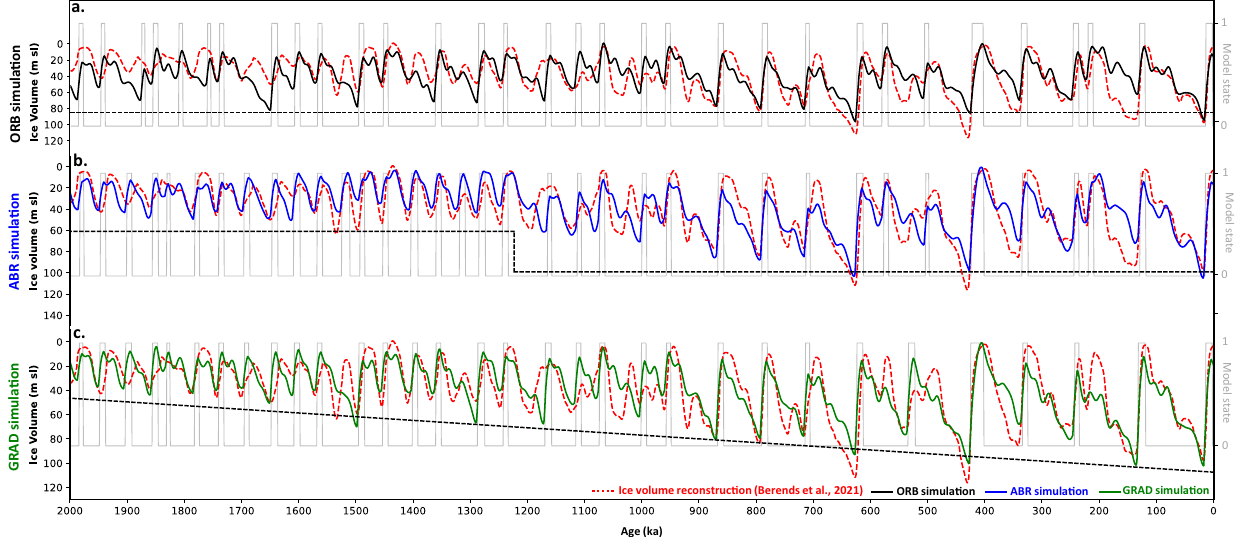
Fig. 1 Simulated and reconstructed global ice volume variations (in metre sea level equivalent, msl) over the last 2 Ma. The ORB ( a , black curve), ABR ( b , blue), and GRAD ( c , green curve) simulations are superimposed onto the reconstructed global ice volume (red dashed curves) from ref. 41 . For each simulation, the grey curve represents the state of the model, deglaciation (1) or glaciation (0) and the evolution of a key model parameter is indicated as a dashed black line. In the ORB simulation, the v 0 parameter is constant throughout the past 2 Ma (dashed black line). In the ABR simulation, the evolution of v 0 can be represented as a step change (dashed black line) between two different values. The optimal timing of the abrupt change in v 0 is at 1220 ka. In the GRAD simulation, the v 0 parameter linearly increases through time over the past 2